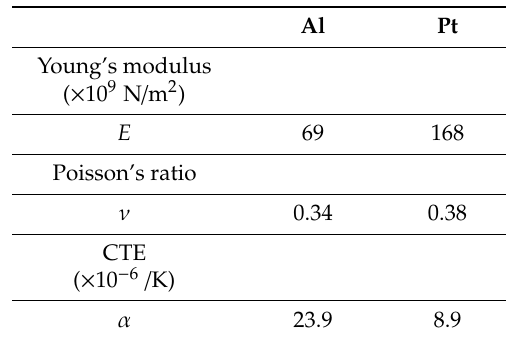
Table 2. Material properties of Al and